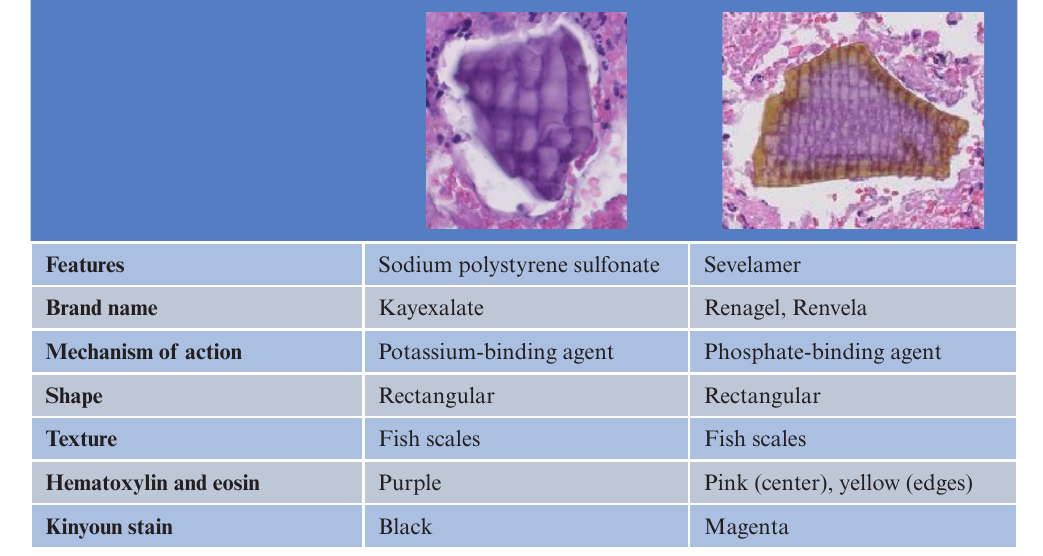
Table 2: Comparison of medical resin appearances in histologic sections.